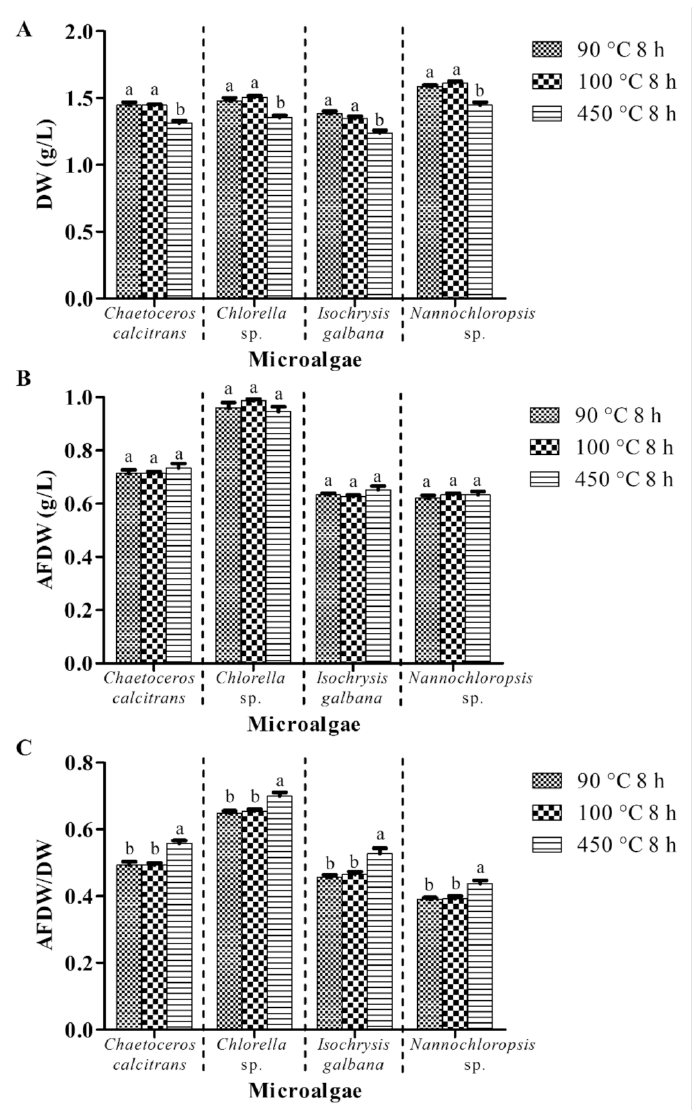
Figure 3. Biomass of four different marine microalgae subjected to the glass microfiber filter that precombusted at different temperatures. ( A ) dry weight ( B ) ash-free dry weight ( C ) ash-free dry weight/dry weight. The other parameters remained constant (with washing process; GF/A; pretreat- ment of GMF for 8 h; 0.5 M ammonium formate; 1:1 culture: washing agent ratio; one washing cycle). Different letters for the respective microalgae indicate a statistically significant difference ( p < 0.05) in terms of biomass among the glass microfiber filter that precombusted at different temperatures. DW, dry weight; AFDW, ash-free dry weight. Data are expressed as mean ± standard error of triplicates (n =